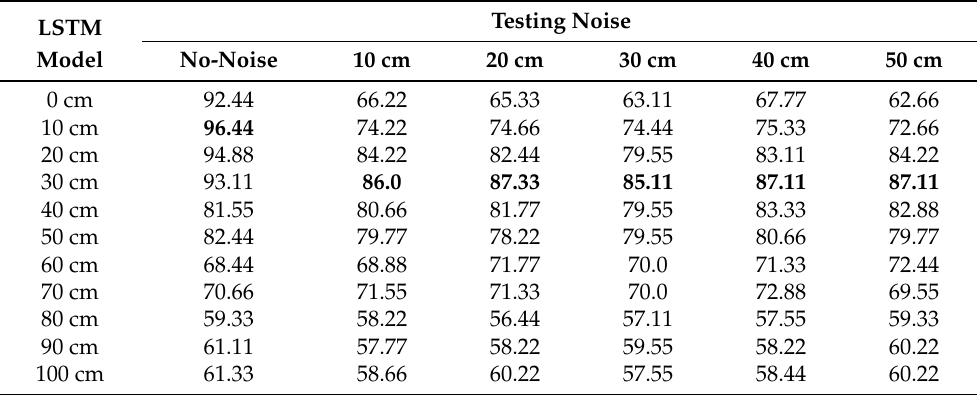
Table 6. Classification accuracy of multiple LSTM models trained with different levels of noise augmentation to the inputs evaluated on noisy testing sets. The best result on each column is highlighted in